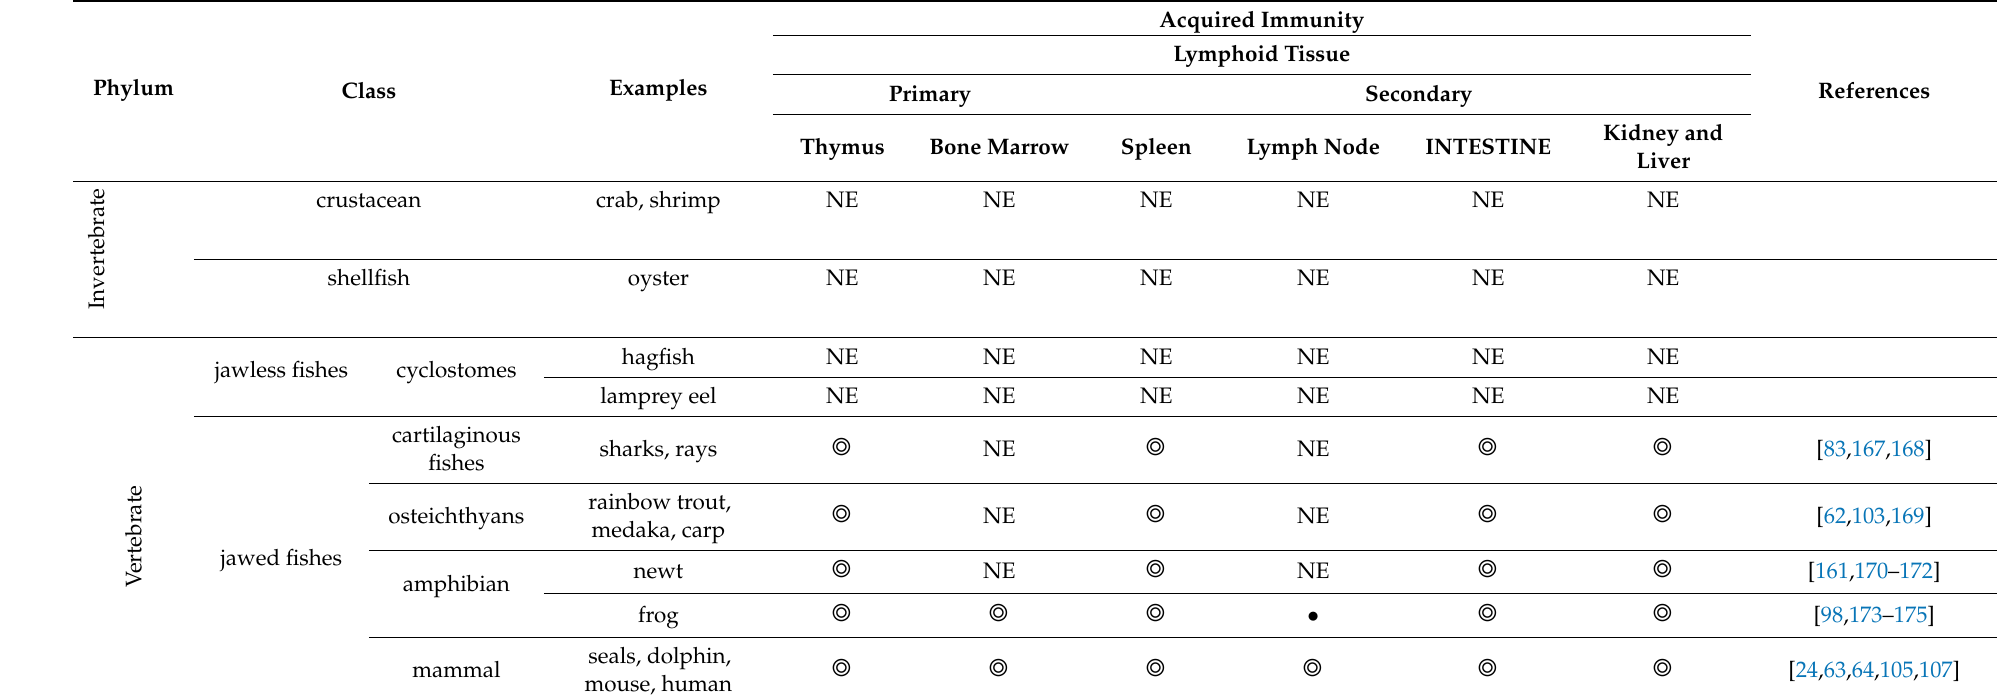
Table 6. Comparison among aquatic organisms of antigen-specific molecules in acquired immune systems.